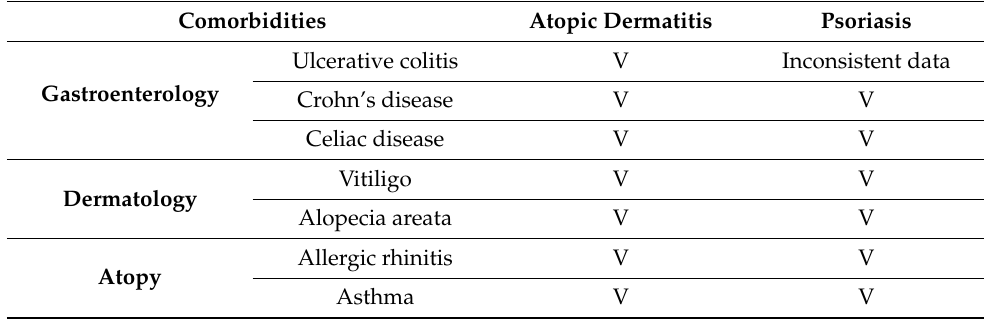
Table 1. Comorbidities of autoimmune diseases between atopic dermatitis and psoriasis.